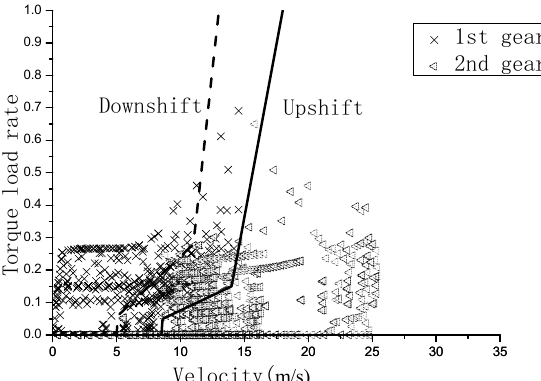
Figure 11. Gear distribution map and shift curve.